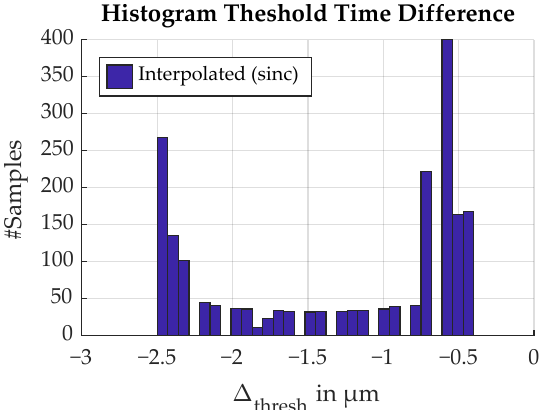
Figure 30. Error in threshold time introduced by sampling the edge transition function at 5MS/s and subsequent interpolation. The shift parameter represents the location of the original analog signal between two sample points.